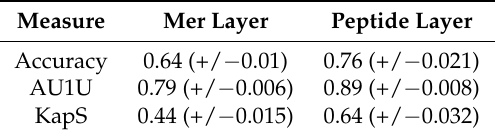
Table 2. Results of fivefold